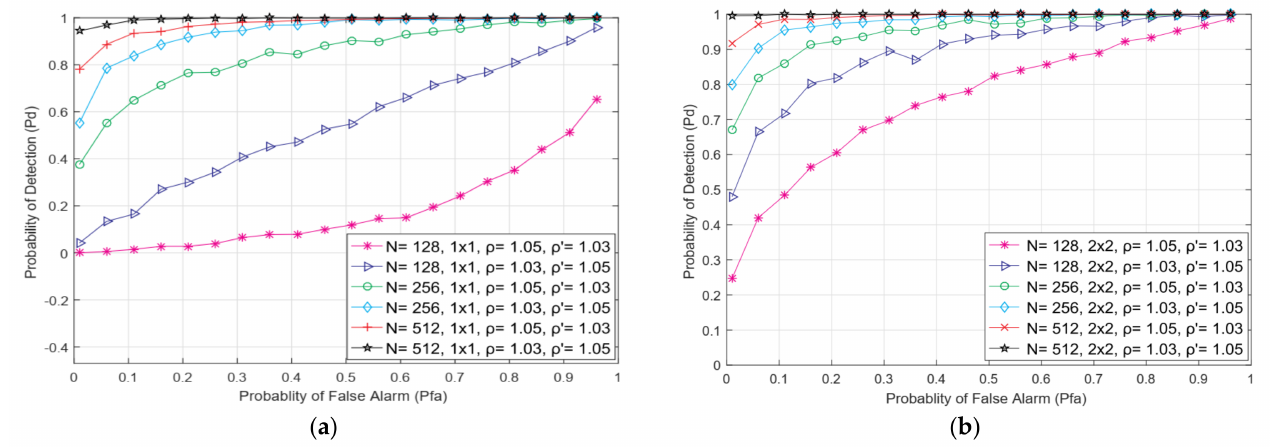
Figure 10. The ROC curves for the various NU and DDT factor combinations and distinct number of detection samples (128, 256, 512) in ( a ) SISO and ( b ) MIMO systems for transmission characterized with QPSK modulation, SNR = − 15 dB and P Tx = 100